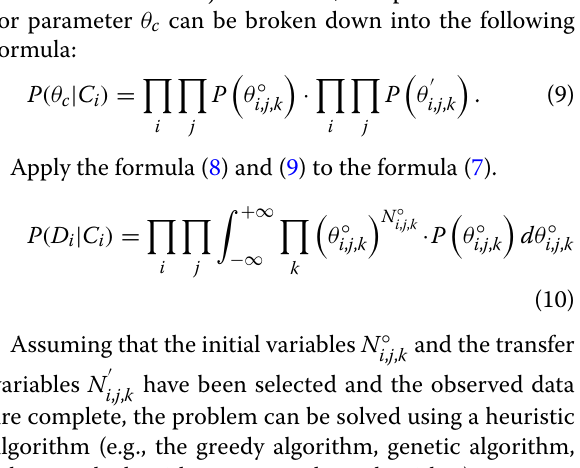
algorithm (e.g., the greedy algorithm, genetic algorithm, tabu search algorithm, or ant colony